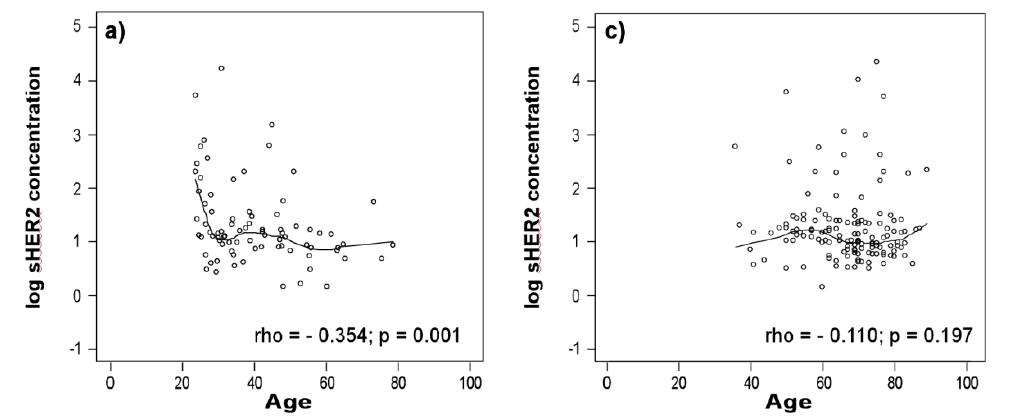
Figure 1. Log soluble human epidermal growth factor receptor 2 (sHER2) concentrations vs. age. Log-transformed serum sHER2 concentrations are plotted against age (years) with nonparametric regression curves for healthy men ( a ), men with non-small cell lung cancer ( b ), healthy women ( c ), and women with non-small cell lung cancer ( d ). Spearman correlations (rho) and p-values are given for each